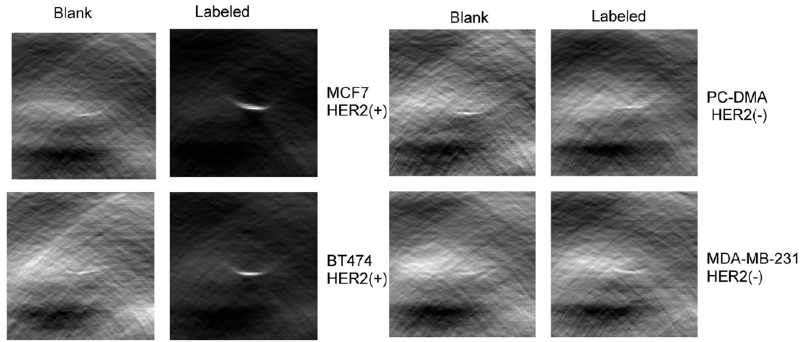
Figure 10. Imaging of HER2+ and HER2 − cell lines with Alexa Fluor 750-Hercepin conjugates. Figure from [92] reproduced with permission from the publisher.